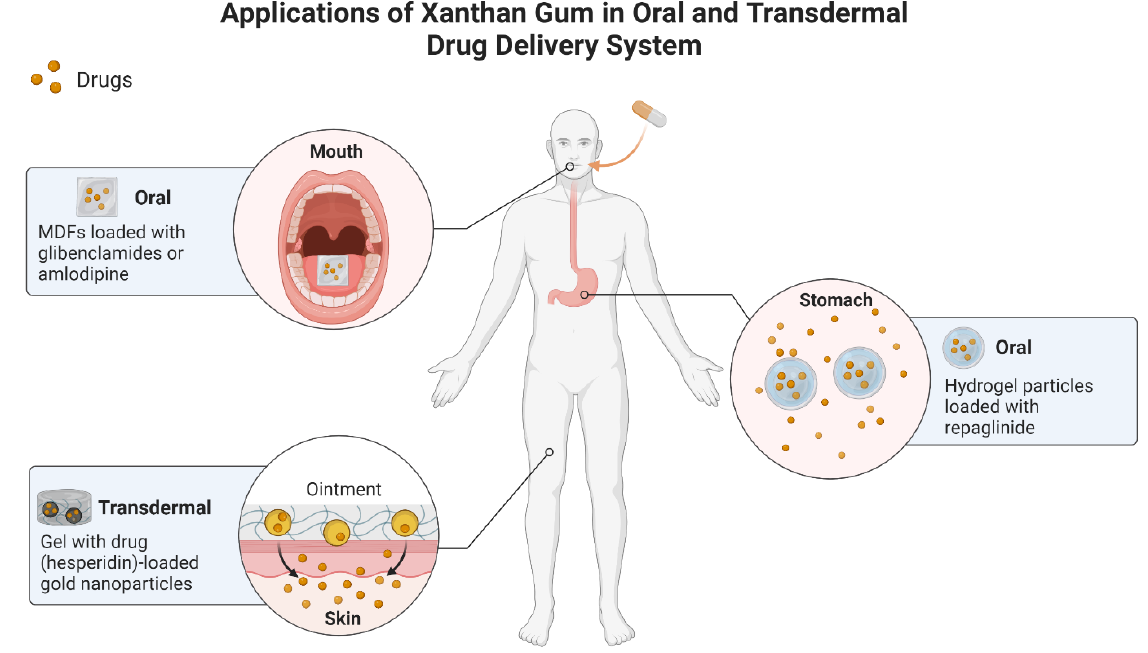
Figure 7. Summary of applications of xanthan gum (XG) in oral and transdermal drug delivery systems (DDS). Oral DDSs can be achieved by incorporating XG-based hydrogel particles loaded with repaglinide to treat type 2 diabetes and XG-based mouth-dissolving films (MDFs) loaded with glibenclamide to treat type 2 diabetes or amlodipine to treat hypertension. Transdermal DDSs can be achieved by incorporating XG-based gel with hesperidin-loaded gold nanoparticles to treat P. vulgaris infection. Table 5. Summary of studies on XG-based DDSs.